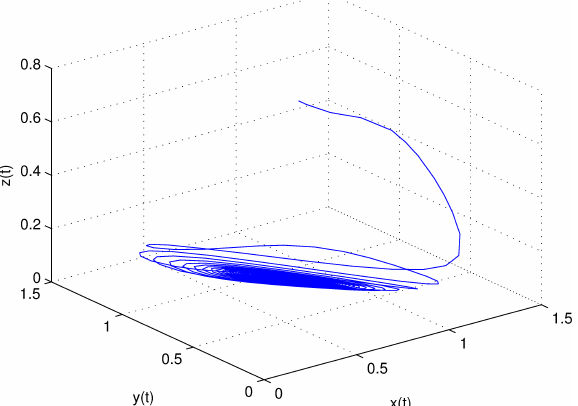
Fig. 4. The phase graph of system .26/ in x (cid:0) y (cid:0) z plane with (cid:28) 1 D 0:5 , (cid:28) 2 D 0:4 and (cid:28) 3 D 0:3 . The initial value is .x.0/ D 0:8;y.0/ D 0:8;z.0/ D 0:7/